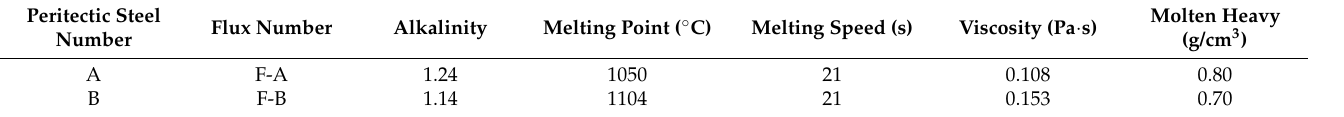
Table 3. Physical properties of mold